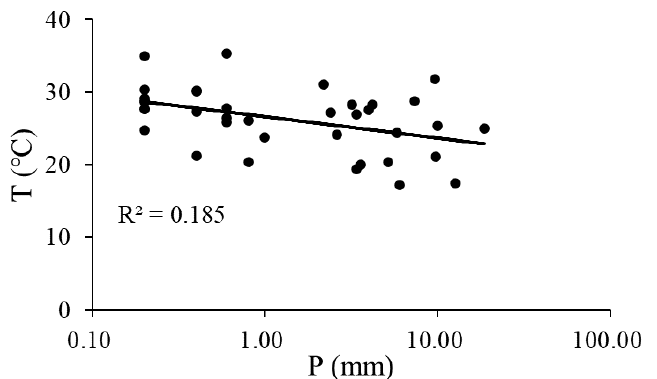
Figure 6. Relationship between precipitation and T on rainy days. P: precipitation, T: air temperature.